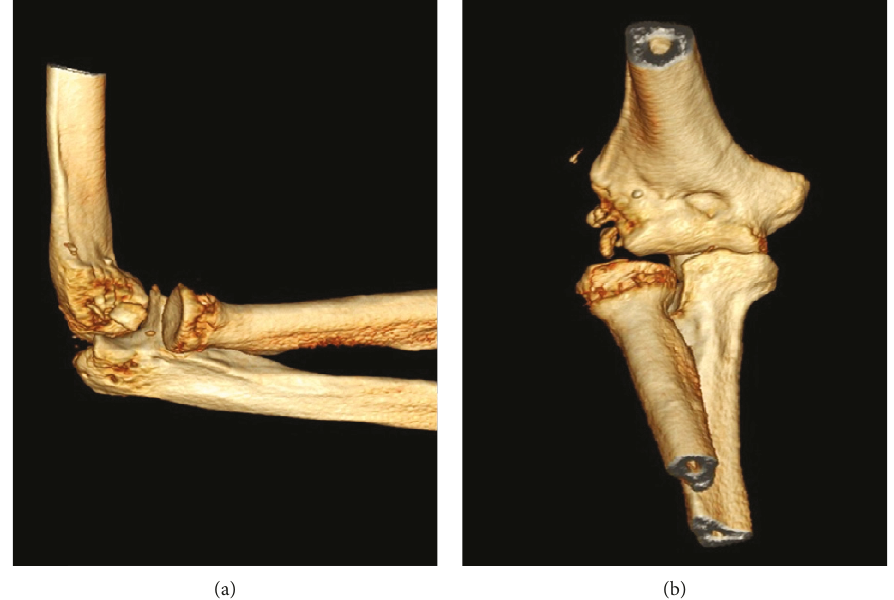
Figure 2: (a) Lateral view and (b) anterior view of preoperative 3-D CT scan reconstruction showing external condyle loss and radial head